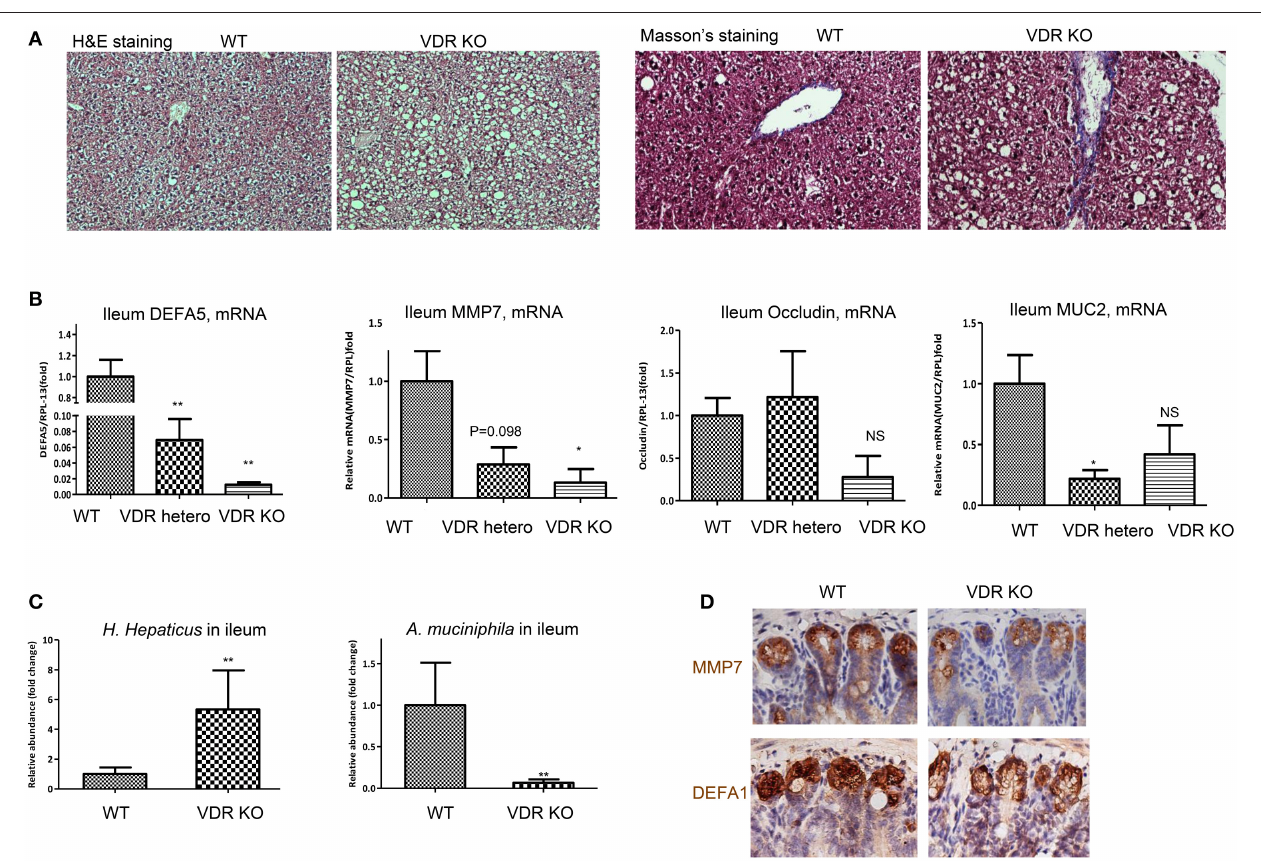
FIGURE 7 | VDR KO mice exhibit ileal dysbiosis, impaired mucosa, and hepatic steatosis. VDR KO and WT littermates in the genetic background (B6.129S4) fed with fortified phosphate and calcium chow for 20w were examined. (A) Representative images of liver tissues, H&E and Masson’s trichrome staining. (B) The mRNA levels of DEFA5, MMP7, occludin, and mucin 2 (MUC2) in the ileum of WT, heterozygote, and homozygous VDR KO were determined by RT-qPCR analysis. (C) H. hepaticus and A. muciniphila in the ileum lumen were determined by 16S rDNA qPCR analysis and presented as relative fold of changes.